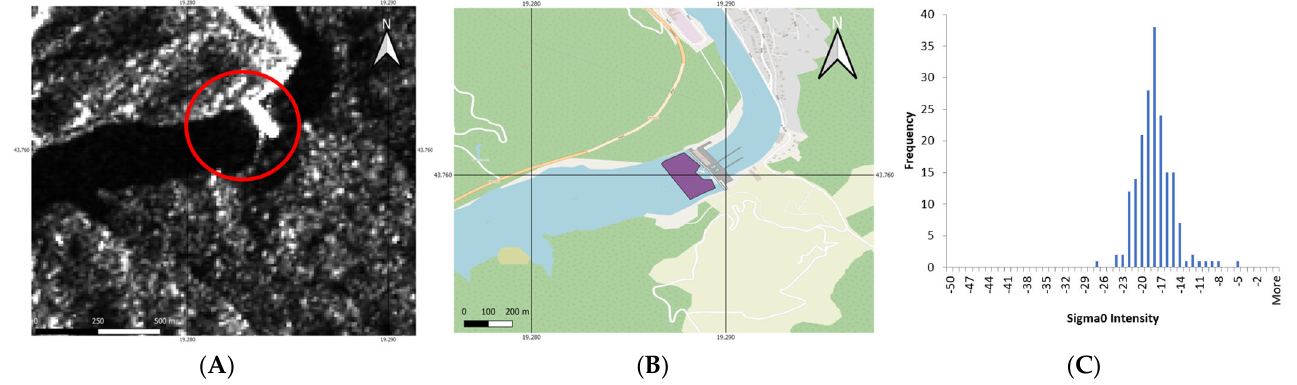
Figure 7. Image from 4 June 2020 in Sentinel ‐ 1 VV Channel showing River Drina hydroelectric dam, Bosnia & Herzegovina. ( A ) VV intensity with red marker highlighting dam and accumulation, ( B ) Polygon used for histogram, and ( C ) Histogram of pixels in polygon (Sentinel ‐ 1, Credits: ESA).